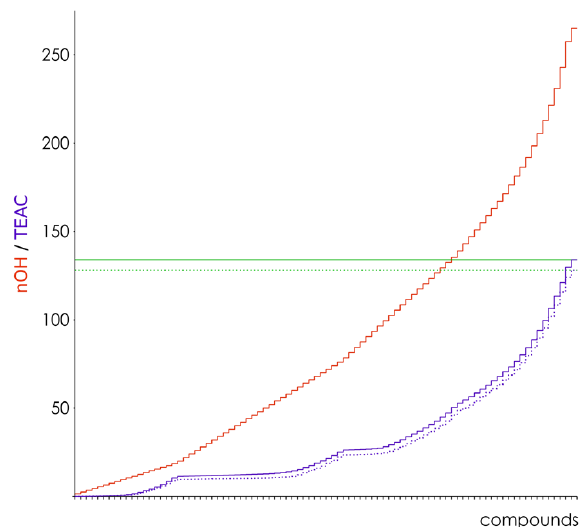
Figure 2. Cumulative graph of the hydroxyl groups (red) and of TEAC values (purple) over all compounds in the ABTS • + (solid line) and DPPH • (dotted line) datasets. The thresholds defined are shown in green lines. For graph clarity, compounds are sorted by the number of OH-groups and by antiradical capacity, and their names are omitted on the graph (the names and numerical data are provided in Supplementary Table S1).